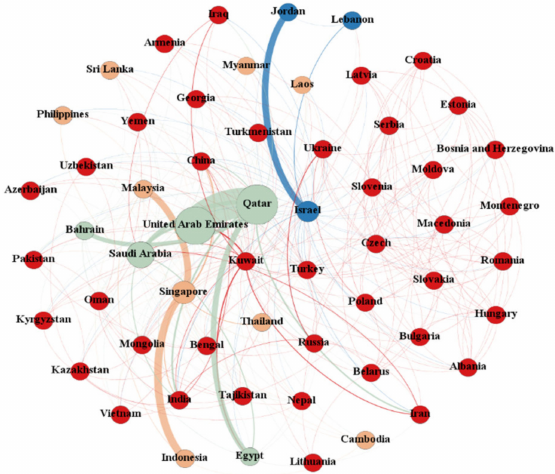
Figure 5. Energy space network of Belt and Road countries in 2014.